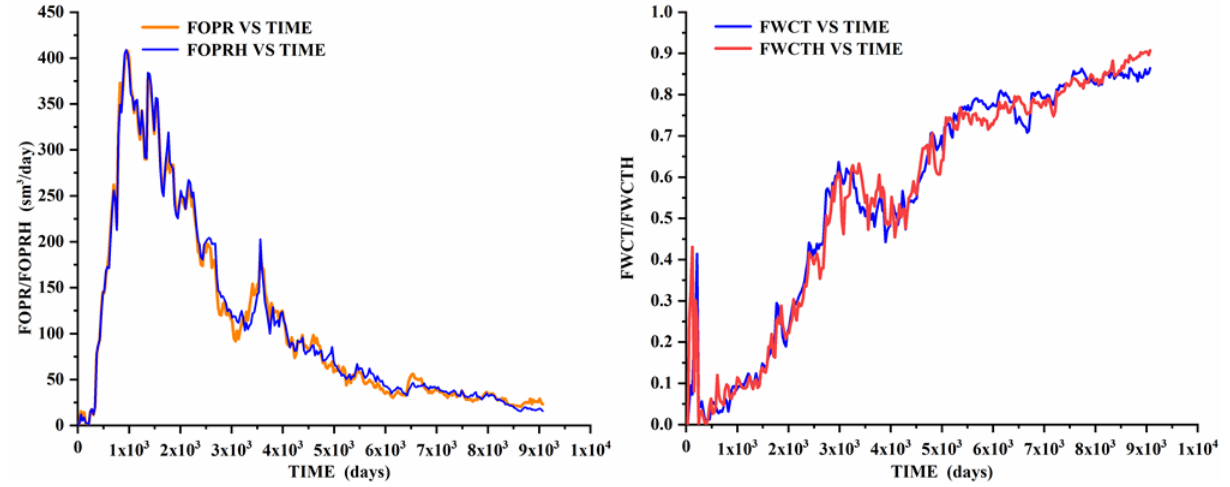
Figure 15. ( a ) Comprehensive water cut fitting; ( b ) fitting of daily oil production in the whole re- gion.